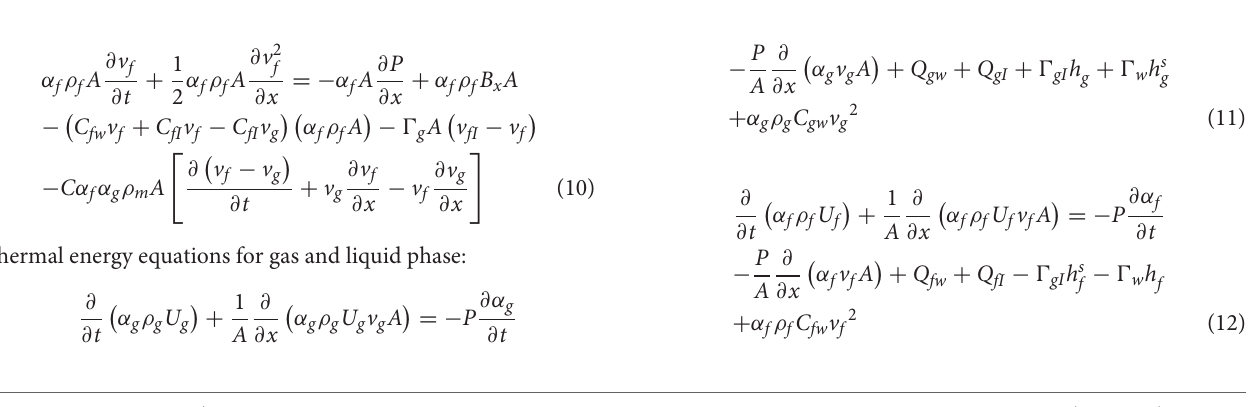
FIGURE 2 | ATHLET code capabilities and structures (Hu et al., 2013). (A) ATHLET code capabilities. (B) Connection between ATHLET and other GRS